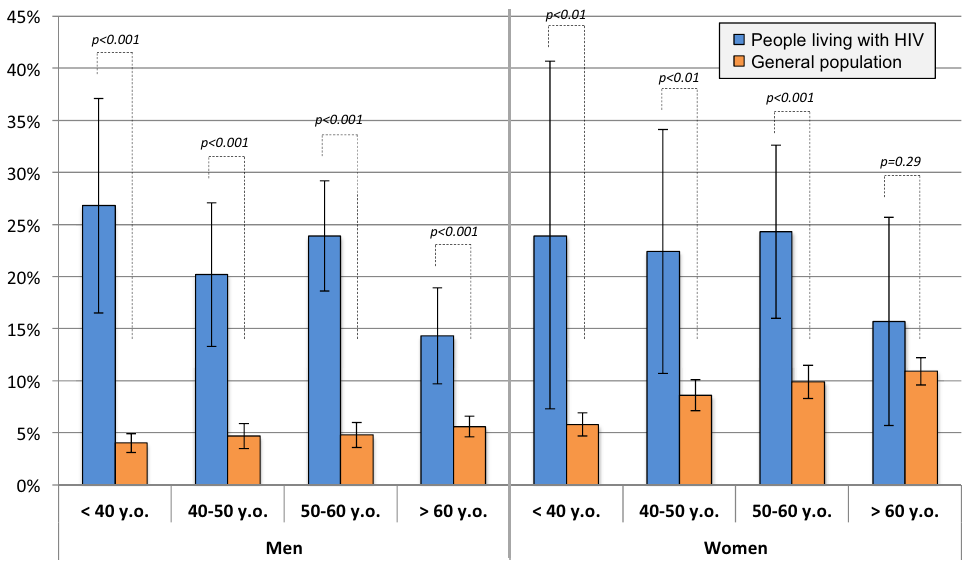
Figure 2. Prevalence of depressive disorder according to PHQ8 in PLWH (QuAliV-DD 2018–2020 study, n = 903), and general population (EHIS-ESPS 2014–2015 survey, n = 12,817), by age and sex. HIV human immunodeficiency virus , PLWH people living with HIV, PHQ-8 Patient Health Questionnaire-8 , y.o. years old . p-value of Chi2 or Fisher test. Microsoft PowerPoint and Excel 2011, version 14.1.0 were used to create this